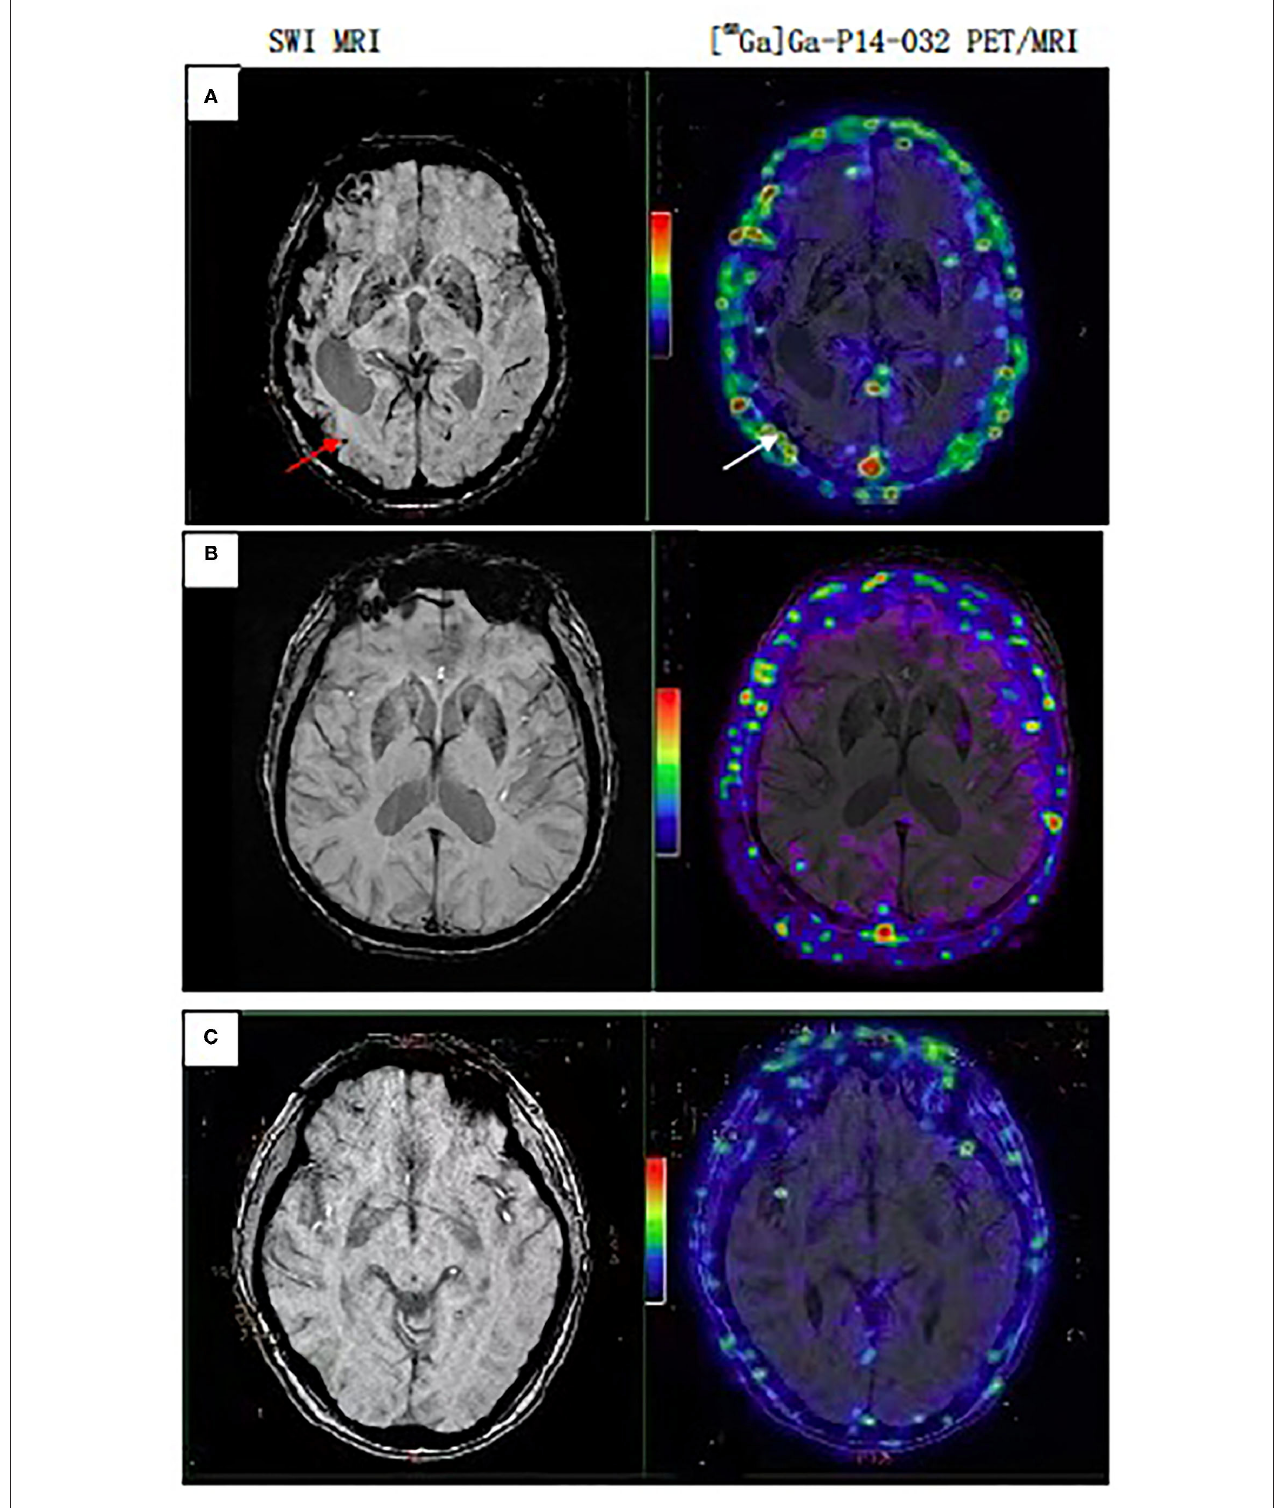
FIGURE 1 | PET/MRI scan sets representative of CAA, AD, Normal subjects. (A) Case 7, female, 70 years, probable CAA patient, multiple CMBs on MRI, white arrow point to the same point to the same area with [ 68 Ga]Ga-p14-032 retention on PET/MRI. (B) Case 5, male, 84 years, AD patient. (C) Case 3, female, 57 years, cognitive normal subject. Cases (B,C) show only non-specific binding in extracerebral tissues.